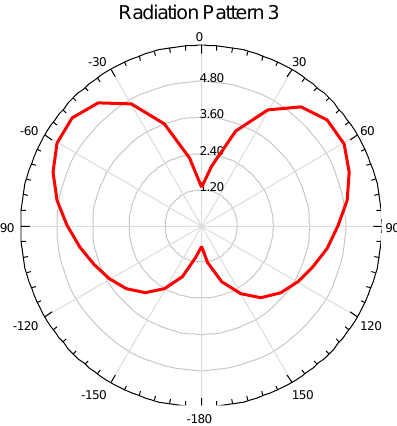
Fig. 6. Radiation pattern of final